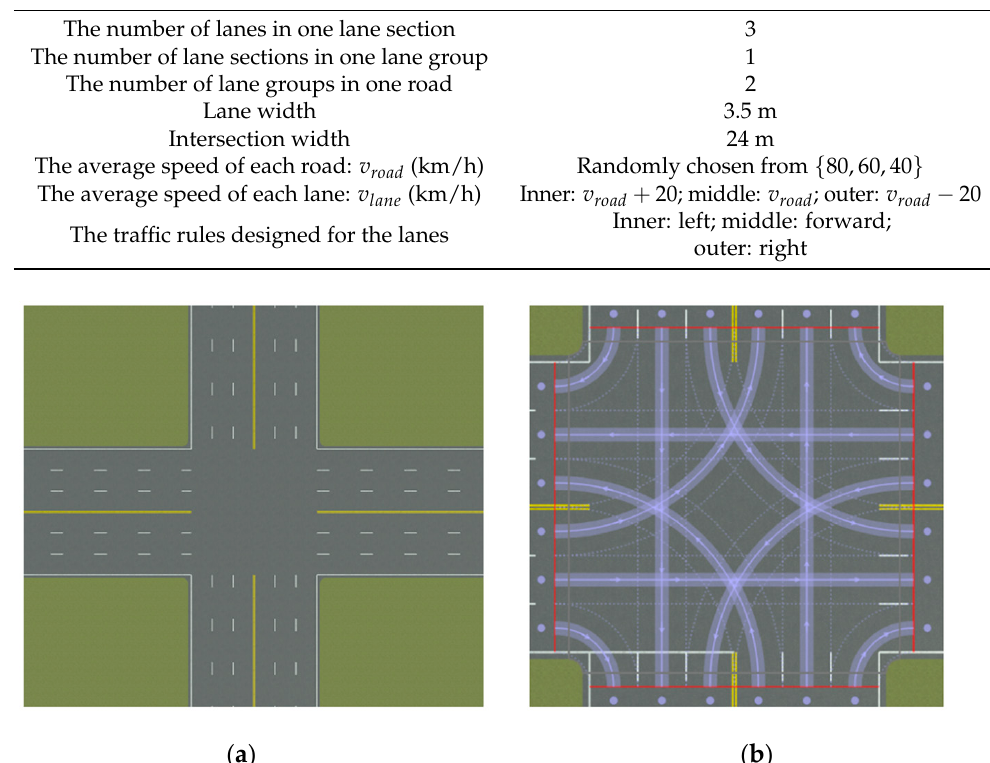
Figure 9. The road network and the corresponding driving scene. ( a ) The road network constructed by RoadRunner. ( b ) The driving scene created using SCANeR studio.